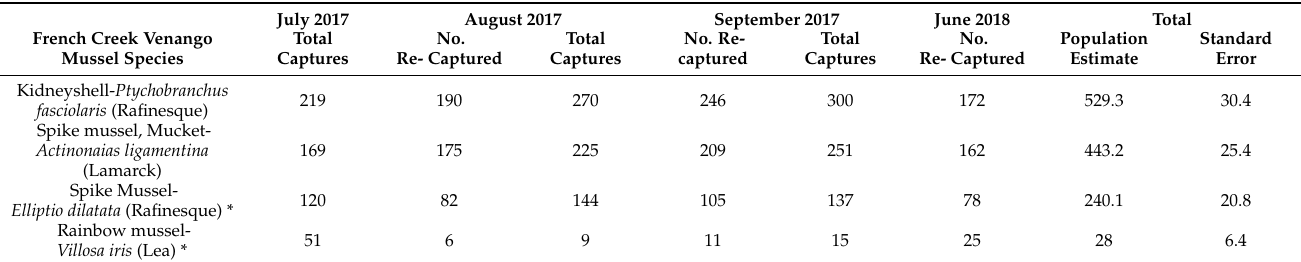
Table 5. Population estimates for the four most common species of mussels at the French Creek Venango sampling site. Species denoted by an asterisk are populations whose population estimate was less than the sample